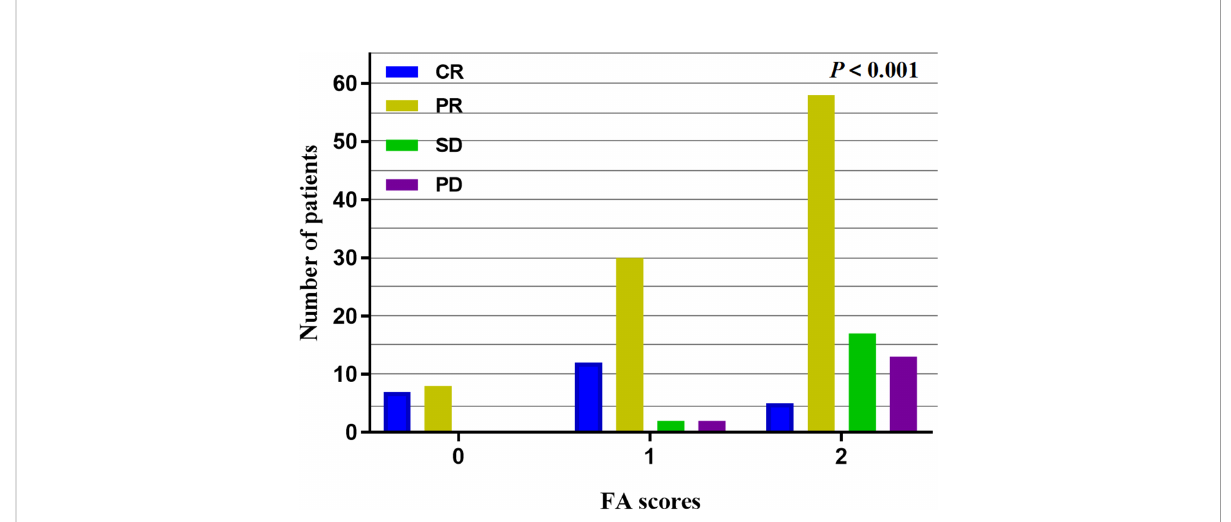
FIGURE 1 Short-term effect analysis in different FA scores, the higher the FA scores, the lower the ORR with P <